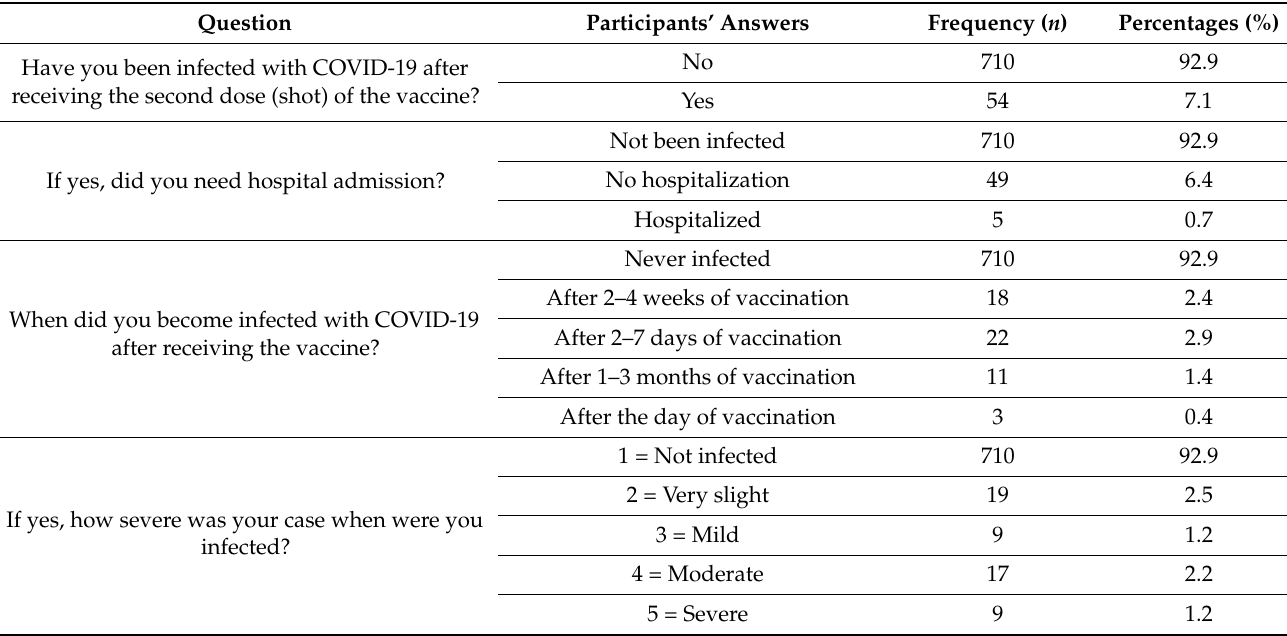
Table 3. Number and percentages of the questions assessing efficacy of the vaccines (total n =